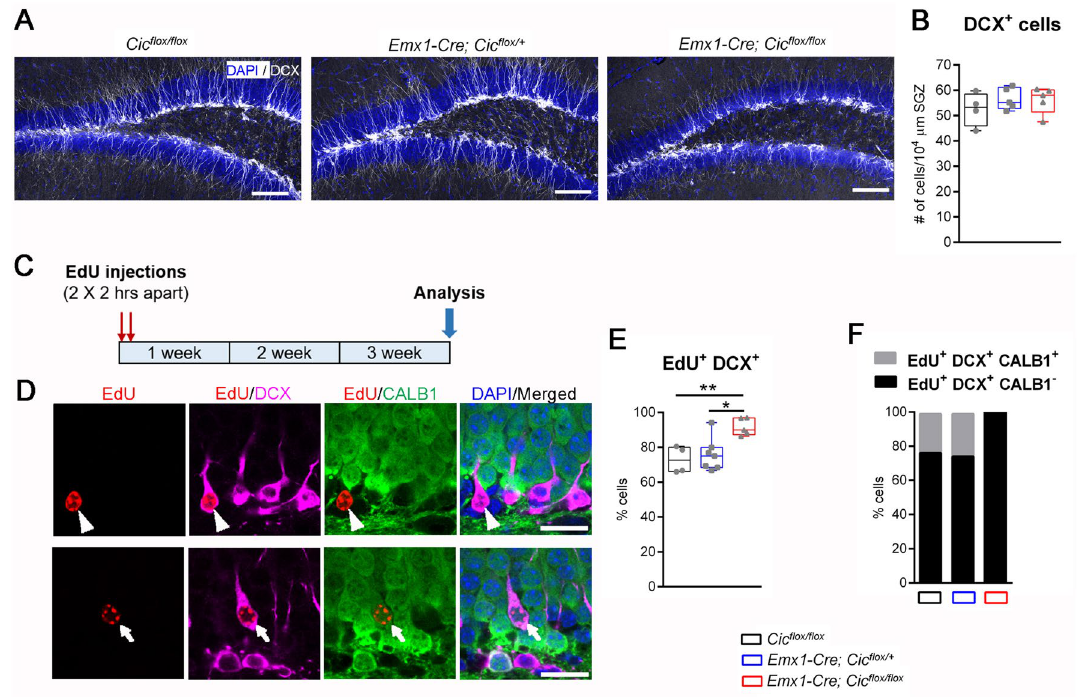
Figure 3. Impaired development of DCX + cells in the Emx1-Cre Cic knockout mice. ( A ) Representative images of the dentate gyrus in the three mouse lines show severe dendritic morphology defects in DCX + cells of the knockout mice. DAPI (blue) and DCX (grey). Scale bars = 100 µm. ( B ) Quantification of the total number of DCX + cells in the three genotypes. No statistically significant difference was found. ( C ) A schematic of the EdU- labelling study. Mice were injected with two doses of EdU that were separated by two hours and were analysed three weeks post injections. ( D ) Representative images of the subgranular zone three weeks post EdU injection showing staining for EdU (red), DCX (magenta), CALB1 (green), and DAPI (blue). The arrowhead points to an EdU-labelled cell that is positive for DCX but negative for CALB1. The arrow points to an EdU-labelled cell that is double positive for DCX and CALB1. Scale bars = 20 µm. ( E ) Quantification of the percentage of EdU-labelled cells that were DCX + in mice of the three genotypes. ( F ) Quantification of the relative proportion of EdU + DCX + cells that were CALB1 - or CALB1 + in mice of the three genotypes. P < 0.0001 using Chi-square test. N = 4–7 animals per group. In ( B ) and ( E ), data are presented in box-and-whisker plots showing all data points, where centre lines represent medians, box limits represent interquartile ranges, and whiskers represent minimum to maximum data ranges. Statistical analyses were performed with one-way ANOVA with Tukey’s post hoc test. * P < 0.05; ** P <